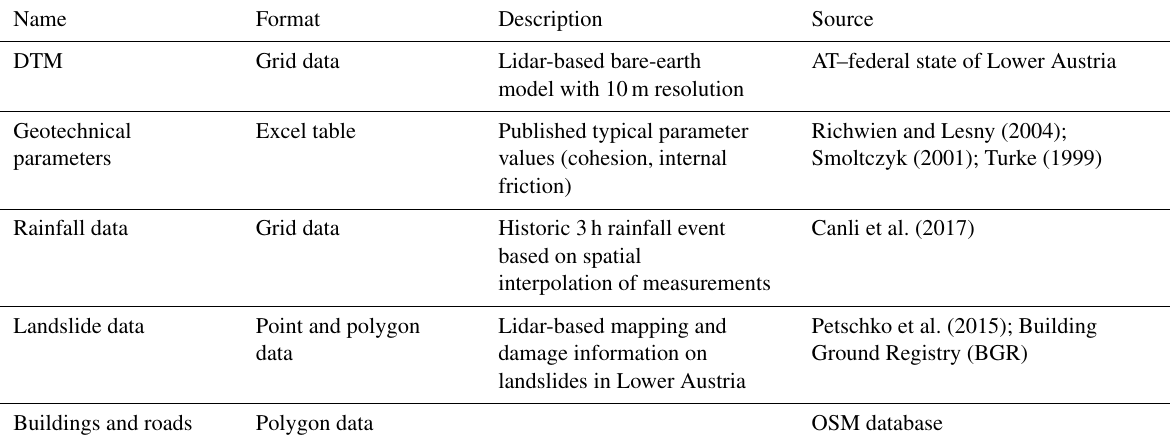
Table 1. Data used in the case